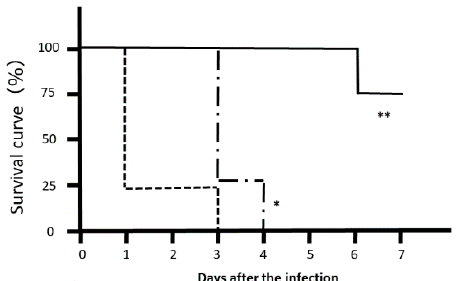
Figure 2. Effects of Lonicera japonica flower bud extract (LJFE) on the survival rate of Citrobacter - infected mice. Eight mice were orally infected with Citrobacter , and their survival rate was plotted. Dotted line, control group without LJFE treatment; dashed line: LJFE-treated group (1 g/kg); solid line, LJFE-treated group (2 g/kg). * p < 0.05, ** p < 0.01 compared with the control group (Kaplan–Meier log rank test).